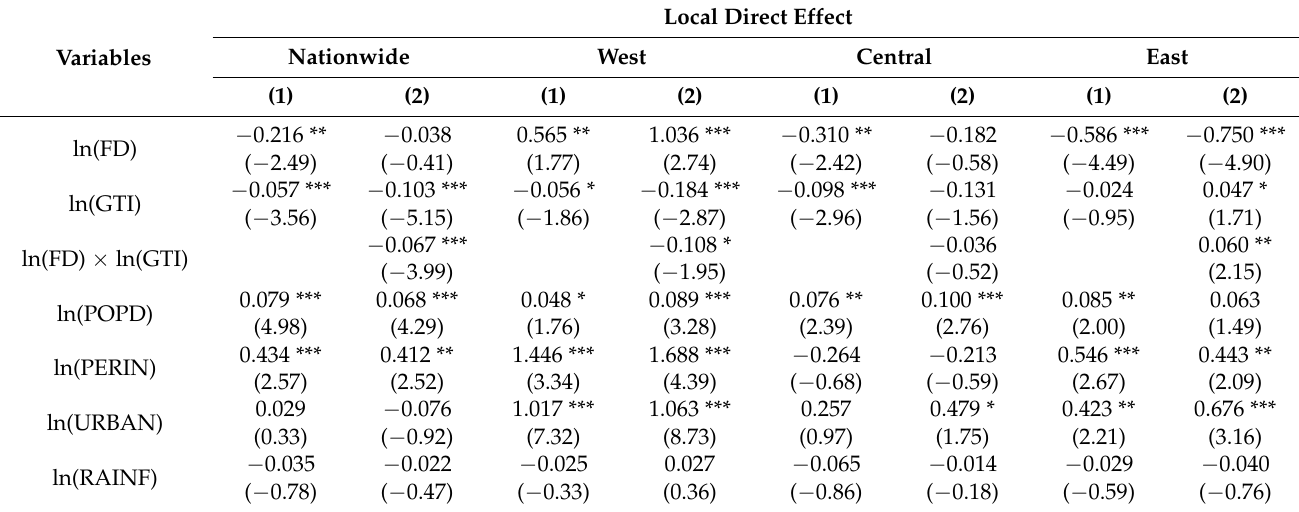
Table 9. Results of stability